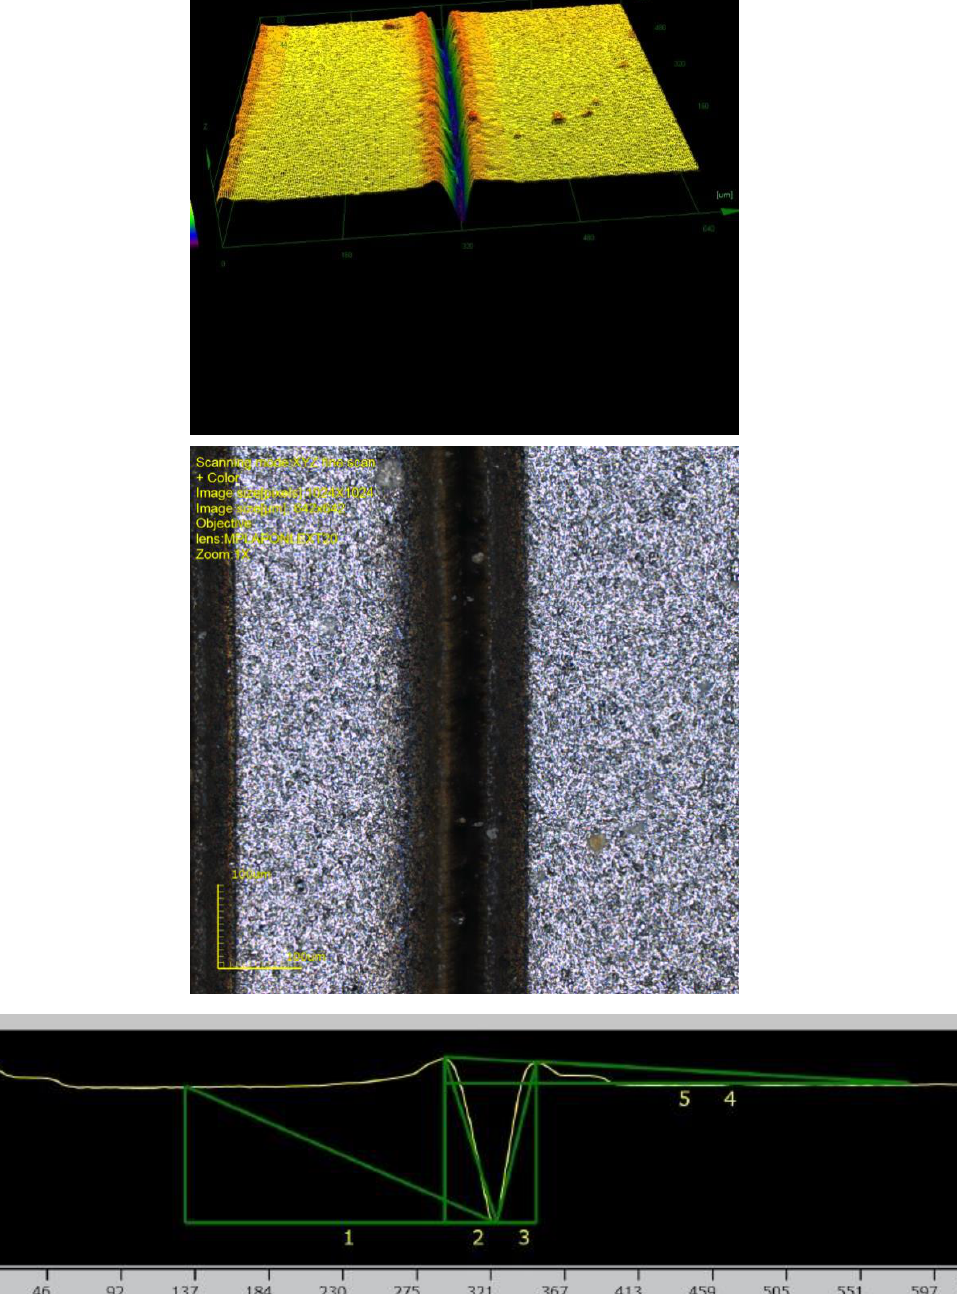
Figure 5. Confocal microscopy images and crater profile of the Si wafers post sub-picosecond micromachining. Laser beam parameters: 650 fs, 343 nm, 200 kHz, 27.5 µJ; processing parameters: 7 mm/s, 15 pattern repetitions.